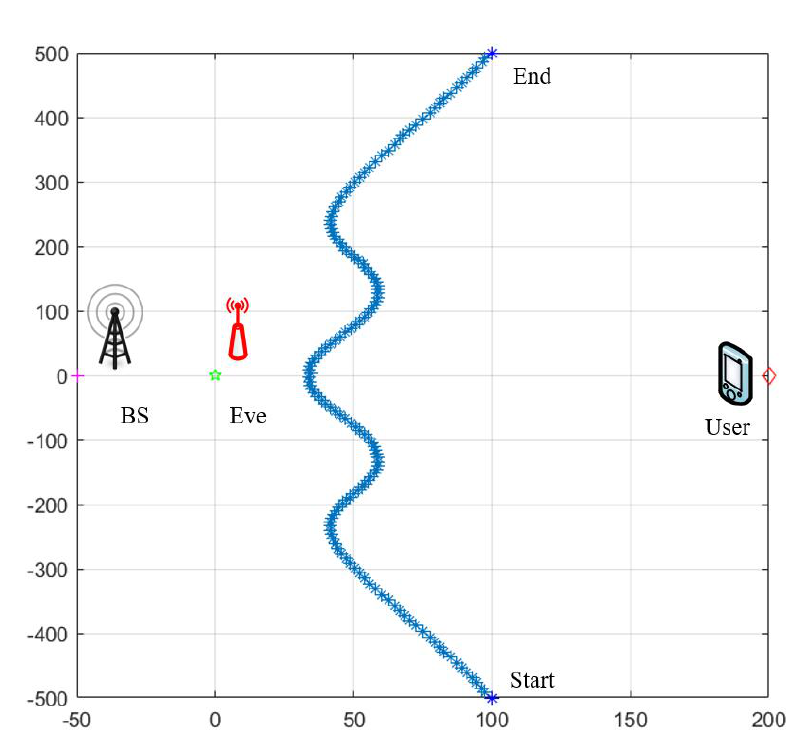
Figure 2. The trajectory of the